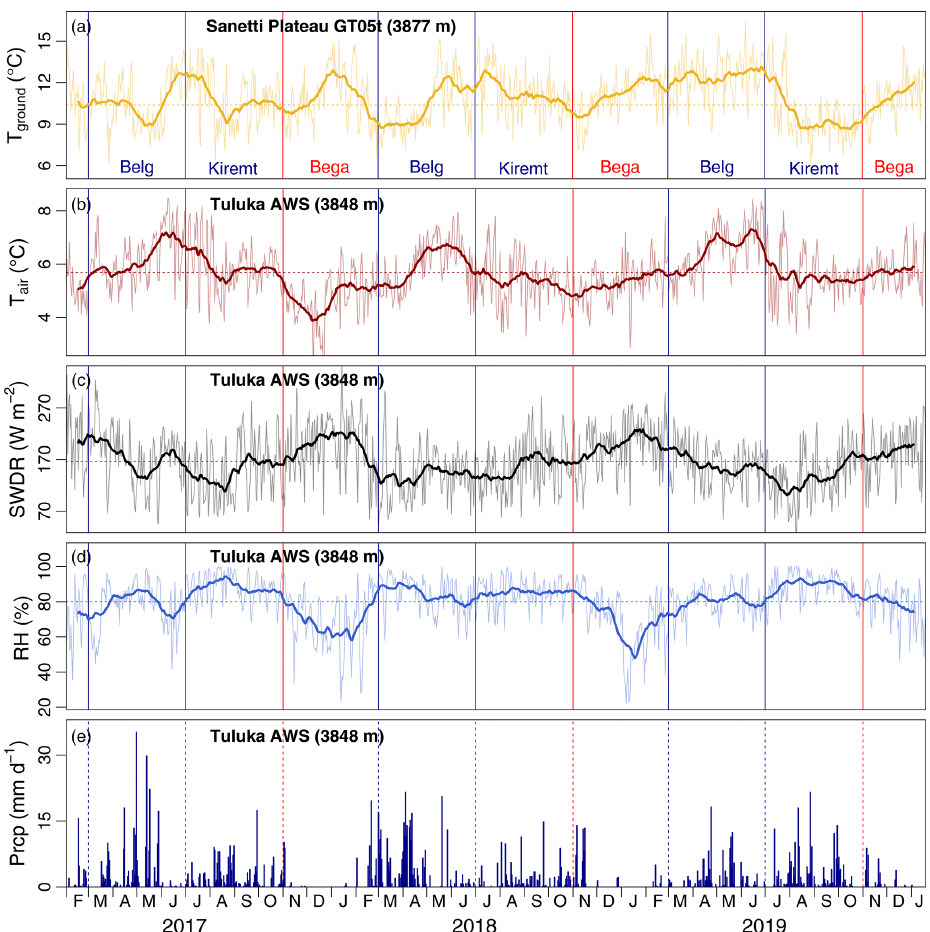
Figure 5. Aggregated mean daily (a) ground temperature, (b) air temperature, (c) short-wave downward radiation (SWDR), and (d) relative humidity (RH) on the southern Sanetti Plateau. The bold lines represent smoothed daily values using a simple moving average with a window size of 31d. The dashed horizontal lines indicate the average of each variable during the measurement period. (e) Daily precipitation (Prcp) sum. Note that the ground temperature data logger GT05t and the Tuluka AWS are about 2km apart. The vertical lines indicate the onset of the different seasons (blue: rainy season; red: dry